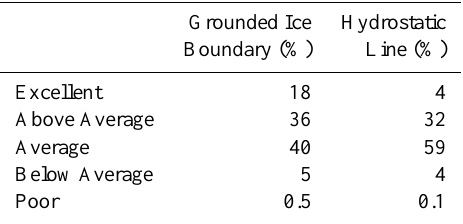
Table 3. Elevation Confidence for points along grounded ice bound- ary and hydrostatic